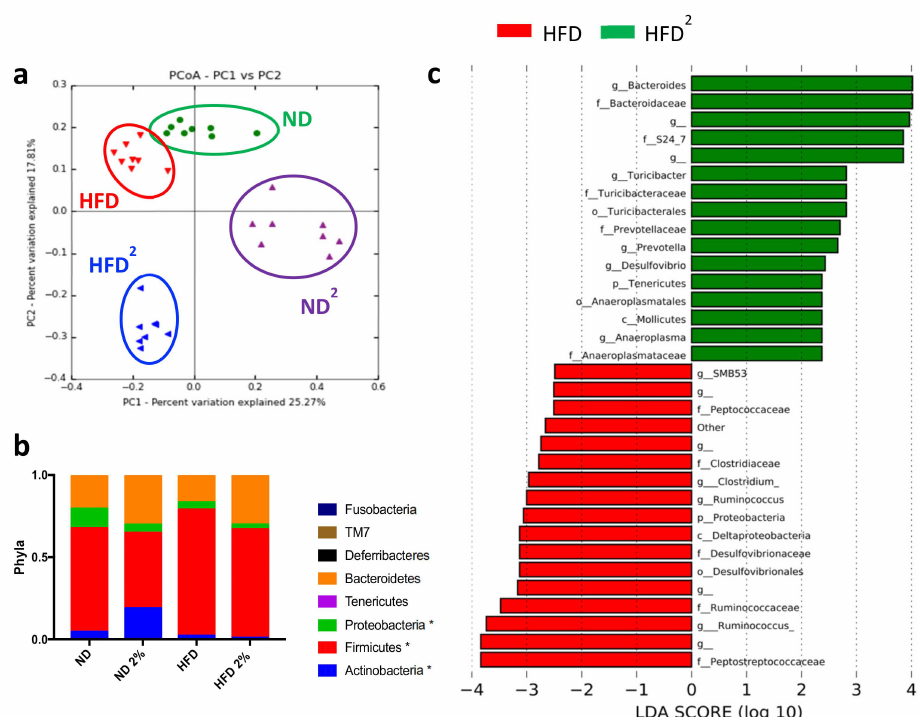
Figure 2. Modifications of the intestinal microbiota by a high-fat diet with 2% pectin. Mice were fed a normal diet without or with 2% pectin (ND, ND 2 ) or a high-fat diet without or with 2% pectin (HFD, HFD 2 ) for 16 weeks. Microbiota analysis was then performed by 16S sequencing: ( a ) unweighted Unifrac distances showing a difference in the composition of fecal microbiota between groups ( p < 0.001, R = 0.58, ANOSIM test, 10,000 permutations, using the first 5 PC): green = ND, purple = ND 2 ; red = HFD, and blue = HFD 2 . ( b ) Histogram showing the relative abundance between phyla (* p < 0.05, represent statistical difference after Bonferonni post-hoc test). ( c ) LDA effect size (LEfSe) for the taxa enriched in HFD (red) and HFD 2 mice (green); only taxa with a, LDA score >2 and p < 0.05, determined by the Wilcoxon signed rank test, are shown. There were eight mice per